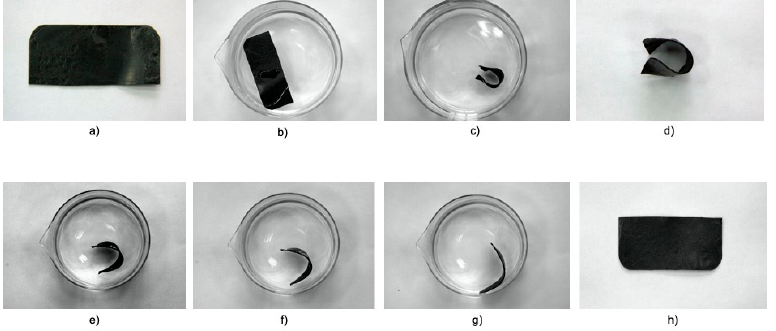
Figure 13. A series of photos demonstrating the shape memory behavior of RS/8411/DCP cross- linked blend: ( a ) Initial sample; ( b ) softening of the sample in hot water; ( c ) fixation of a temporary shape by the emergence in cold water; ( d ) fixed temporary shape; ( e ) immersing the temporary sample in hot water to restore its initial shape; ( f , g ) recovering of the sample shape at various stages; ( h ) sample after final recovery.